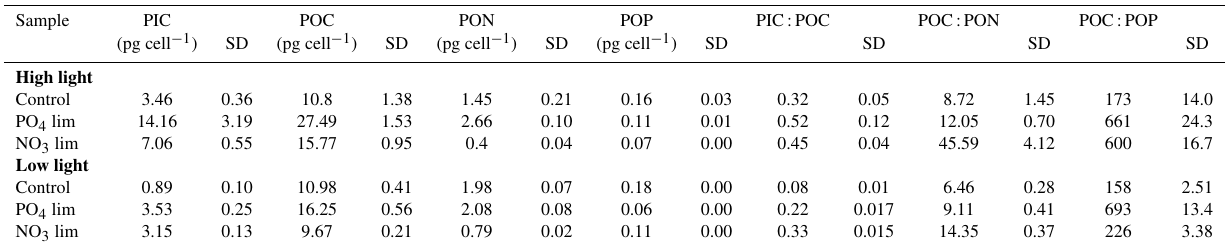
Table 3. Values of Q min (which correspond to the cellular PON (POP) at the end of the experiment: values measured and calculated) and the R parameters obtained with the best-fit indicated for N- and P-limited experiment (high light = HL and low light = LL). Q min R Strain Light Limitation